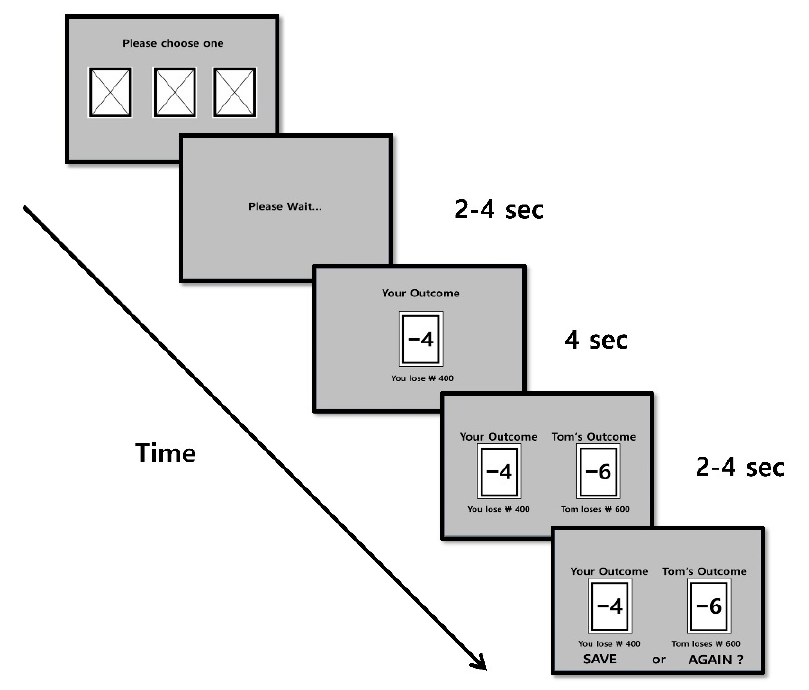
Figure 2. One representative trial of the social comparison task. In each trial, a participant is instructed to choose one of three cards. Two to four seconds after the choice, the outcome of the participant was presented for 4 s and followed by a display of the outcomes for the participant and the partner for 2–4 s. Thereafter, the participant was prompted to decide whether to save (accept) or repeat (reject) the current outcome.